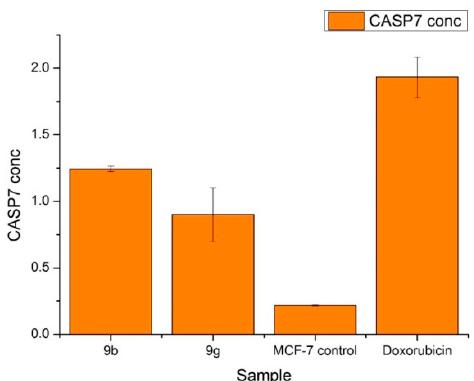
Figure 5. Casp7 (ng / mL) quantitative estimation of MCF-7 treated with IC 50 of compound 9b (19.8 Figure 5. Casp7 (ng/mL) quantitative estimation of MCF-7 treated with IC 50 of compound 9b (19.8 µ g / mL) and IC µ g / mL) compared to untreated cells and cells treated with reference to the 50 of 9g (26.2 µg/mL) and IC 50 of 9g (26.2 µg/mL) compared to untreated cells and cells treated with reference to drug Doxorubicin ( p < the drug Doxorubicin ( p < 0.05).